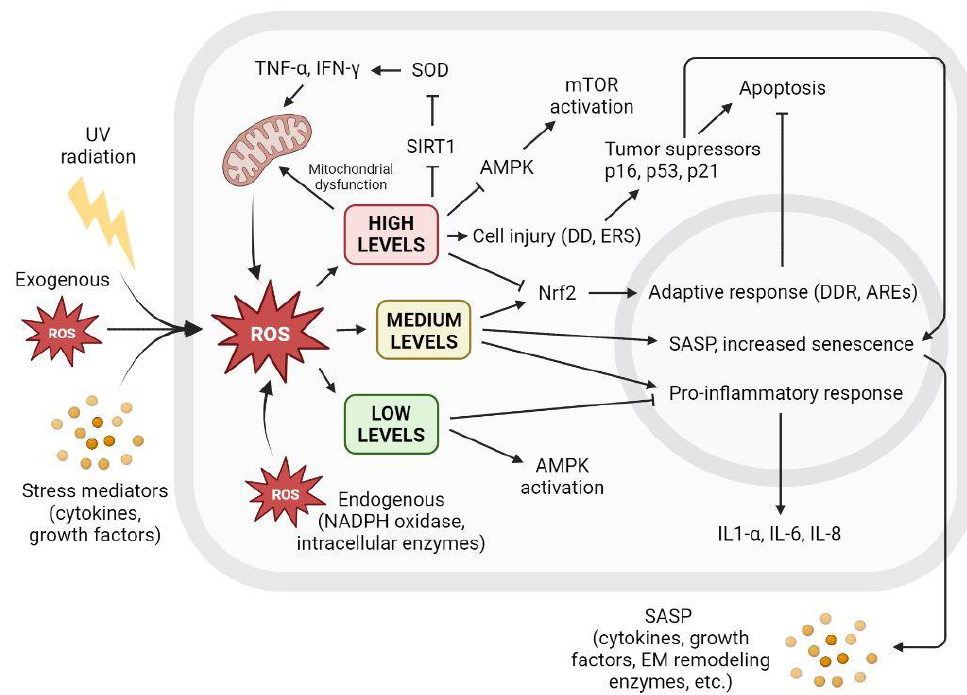
Figure 5. The level of intracellular ROS triggers adaptive response, apoptosis, or SASP. Intracellular ROS levels can vary depending on several factors, including extracellular factors such as exposure to UV radiation, high levels of oxidative stress, or proinflammatory environments with the presence of cytokines or growth factors. ROS are also produced intracellularly as part of normal cellular processes or at elevated levels derived from dysfunctional mitochondrial activity, as well as increased by NADPH oxidase activity or other intracellular enzymes. Low ROS levels activate AMPK and inhibit proinflammatory response. Low ROS levels do not promote cell senescence and contribute to redox homeostasis. Medium ROS levels activate Nrf2 and promote adaptive cellular response to fight ROS and prevent apoptosis, activate proinflammatory response, and increase SASP and its paracrine signaling, promoting cell senescence. High ROS levels cause mitochondrial dysfunctions that generate more ROS; inhibit AMPK, resulting in mTOR activation; and cause widespread cell damage by increasing cellular stress and the concentration of tumor suppressors and cell cycle arrest proteins, leading to apoptosis. AREs: AU-rich elements; AMPK: AMP-activated protein kinase; DD: DNA damage; DDR: DNA damage response; EM: extracellular matrix; ERS: endoplasmic reticulum stress; IFN- γ: interferon gamma; IL: interleukin; mTOR: mammalian target of rapamycin; NADPH: nicotinamide adenine dinucleotide phosphate; ROS: reactive oxygen species; SIRT1: sirtuin 1; SOD: superoxide dismutase; TNF- α: tumor necrosis factor alpha; UV: ultraviolet.